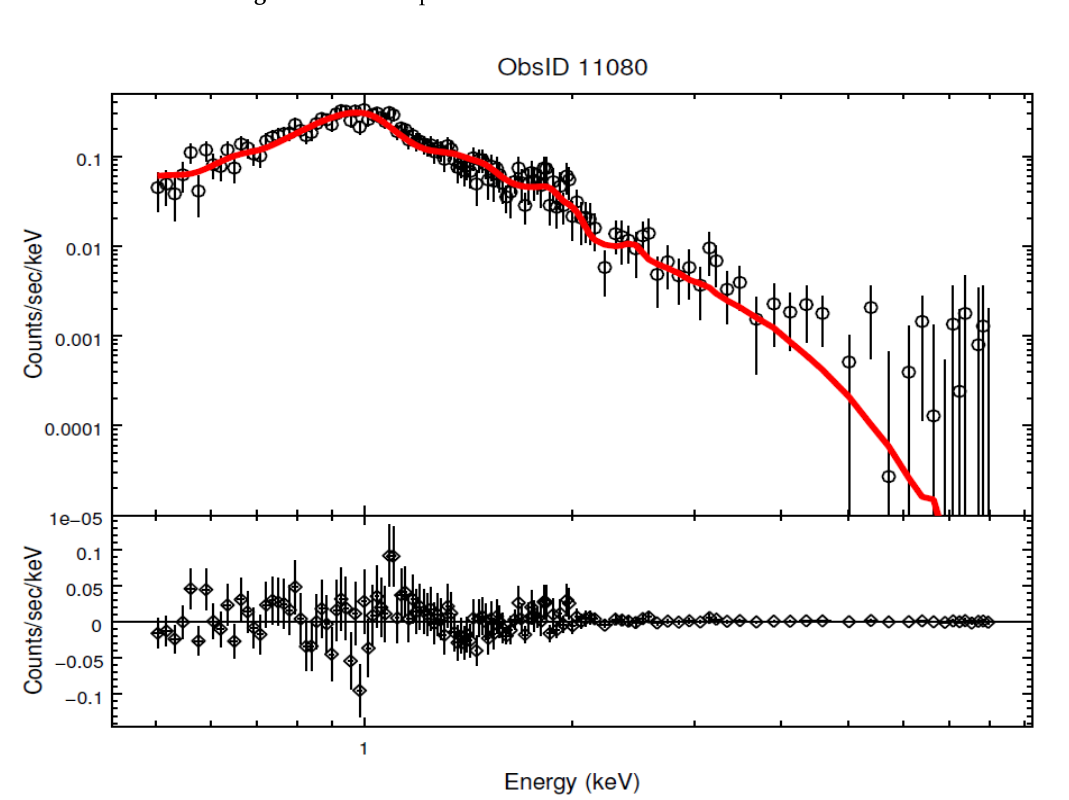
Figure 6. TV Cas Spectrum from Chandra Observation ID